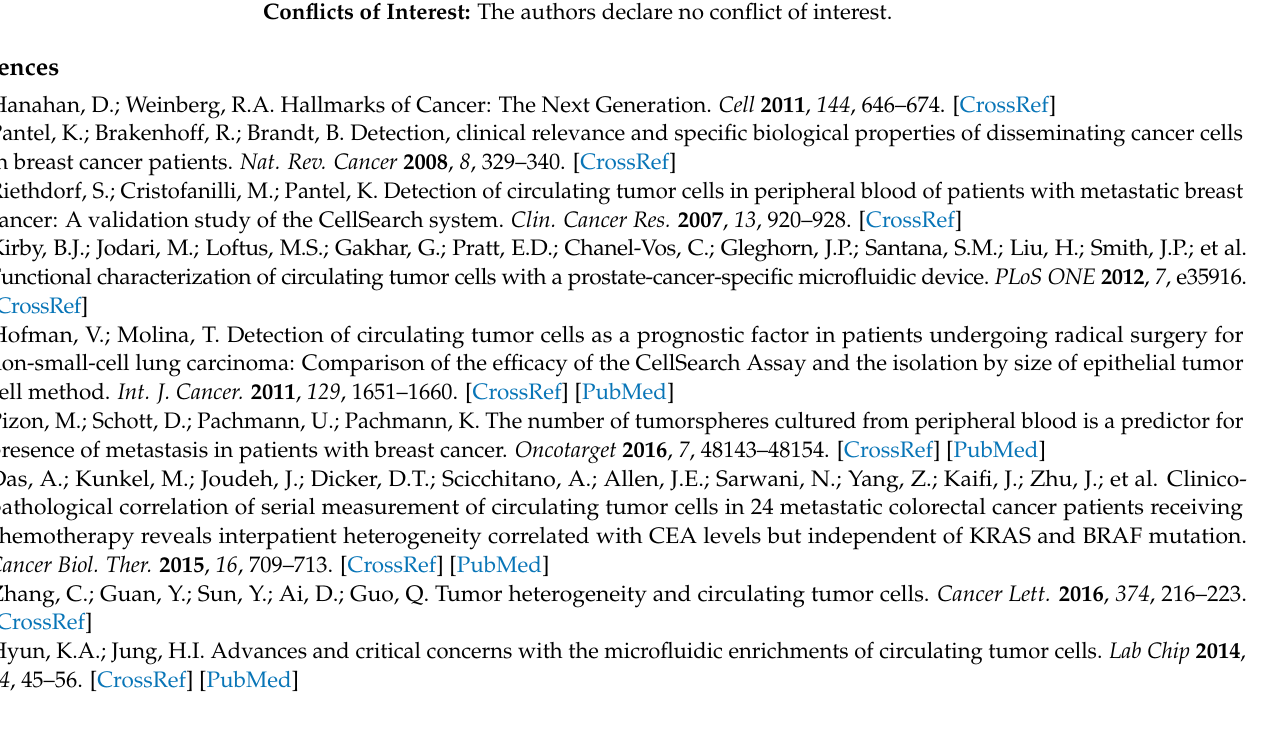
rate profiles used for filtration experiments, Figure S3: Static fluid simulation of two filter holder designs, Figure S4: Capture rate of the HCT116 cells spiked into blood, Figure S5: Filtration set-up mounted on a fluorescence microscope, Figure S6: Recovery rates of cells spiked into PBS, Figure S7: Comparison of identification and correct counting of cell